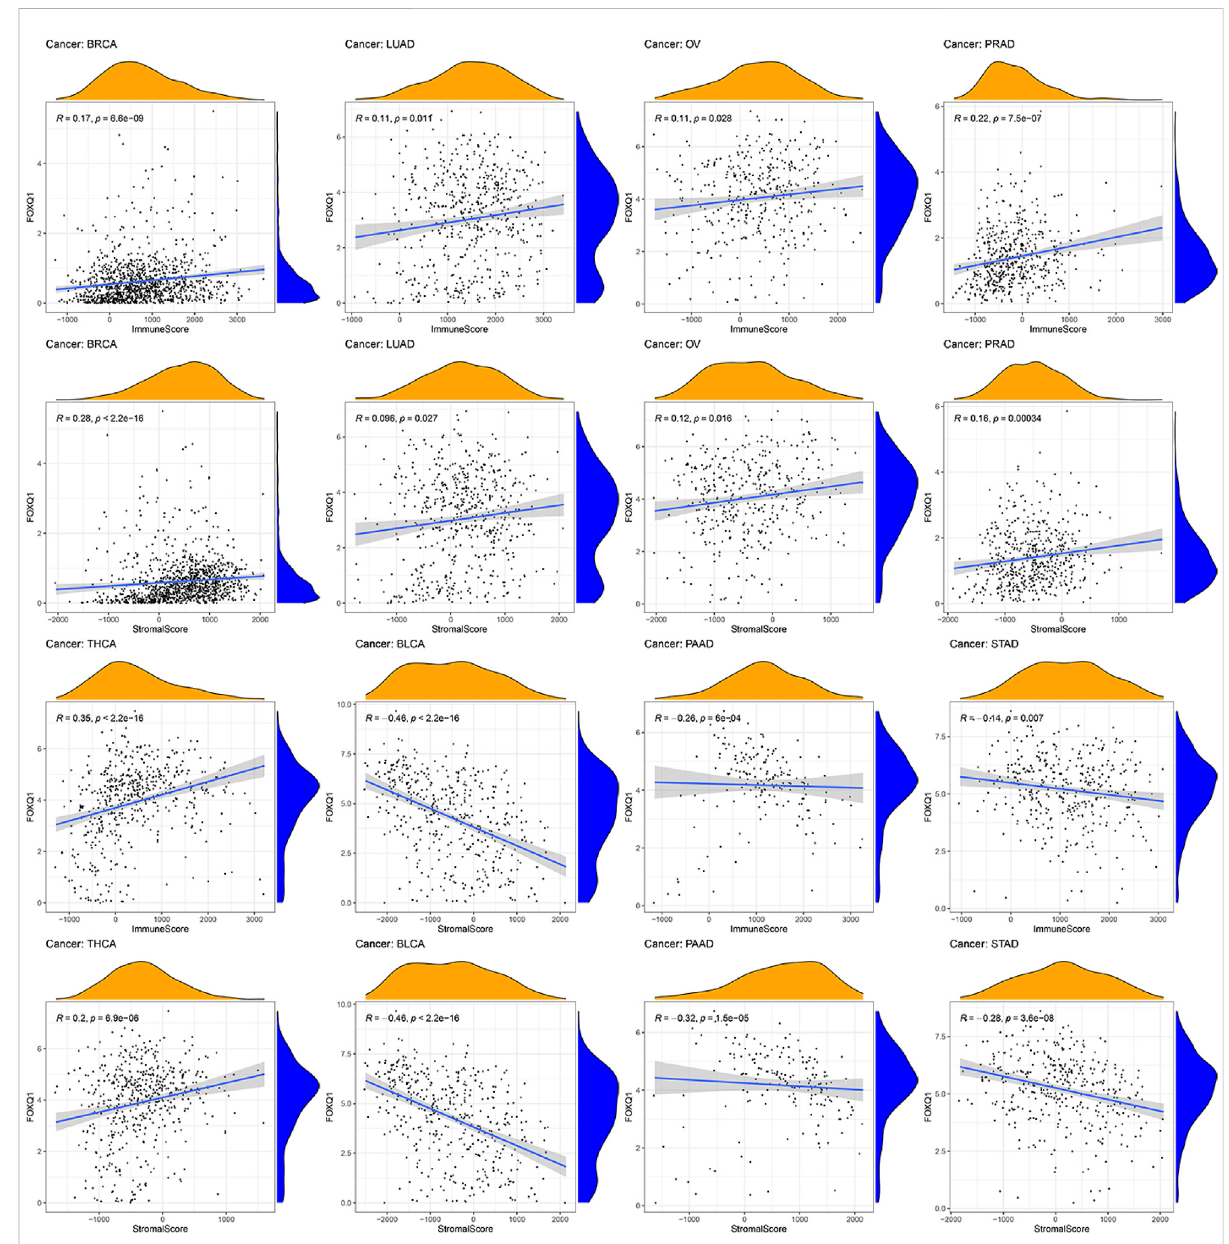
FIGURE 9 Relationship of forkhead box Q1 (FOXQ1) expression with tumor microenvironment across different cancer types. FOXQ1 expression was positively correlated with stromal score and immune score in breast cancer, prostate adenocarcinoma, thyroid carcinoma, lung adenocarcinoma, andovarianserouscystadenocarcinomaandwasnegativelycorrelatedwithbladderurothelialcarcinoma,pancreaticadenocarcinoma,andstomach